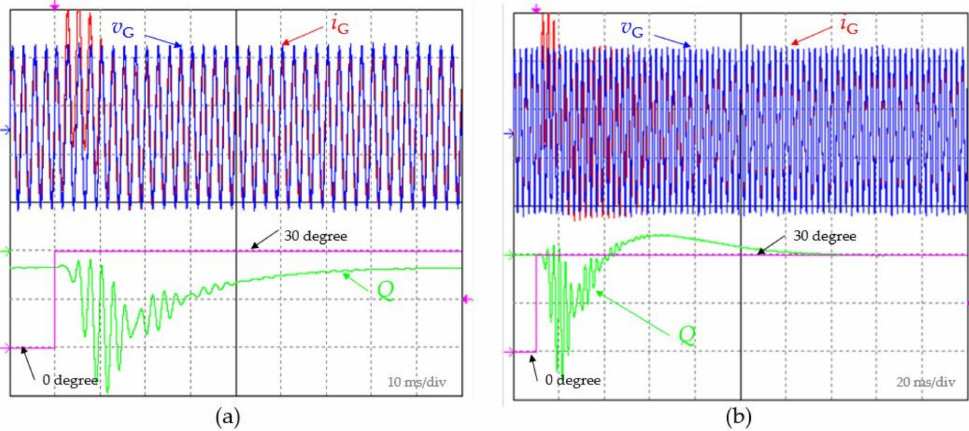
Figure 11. Dynamic response of the system registered for the phase jump of 30 degree: waveforms of the grid voltage v G and grid current i G , the reactive power Q ; the signal activating the phase jump from 0 to 30 degree registered for ( a ) classically controlled grid converter without reactive power compensation and for ( b ) proposed